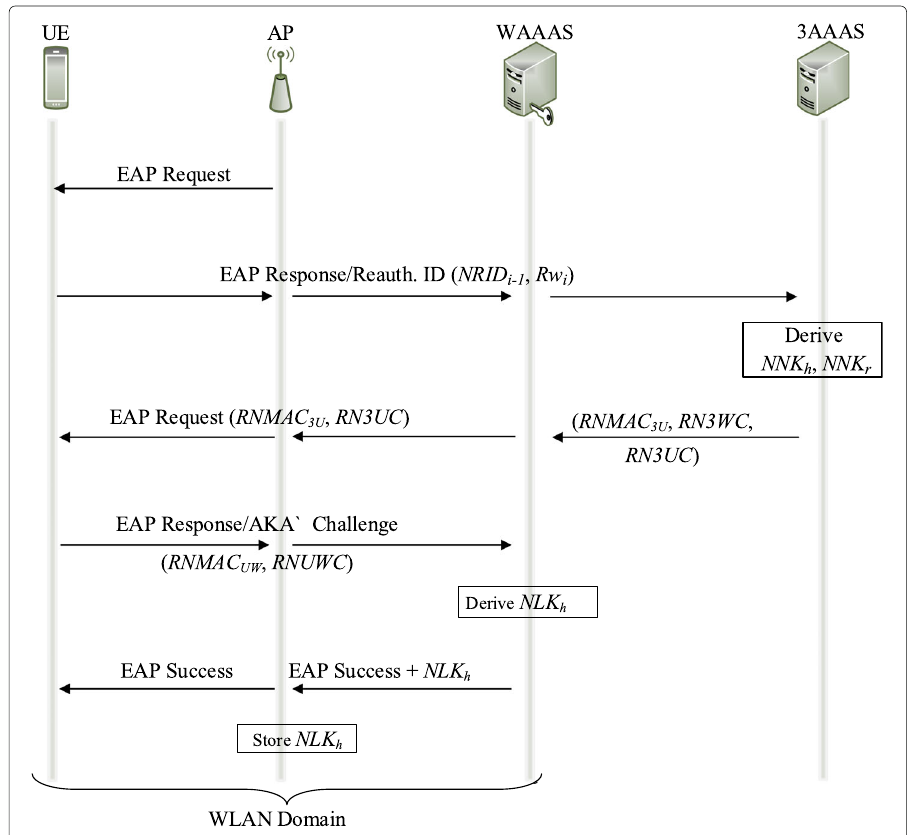
Fig. 4 Inter WLAN re-authentication protocol